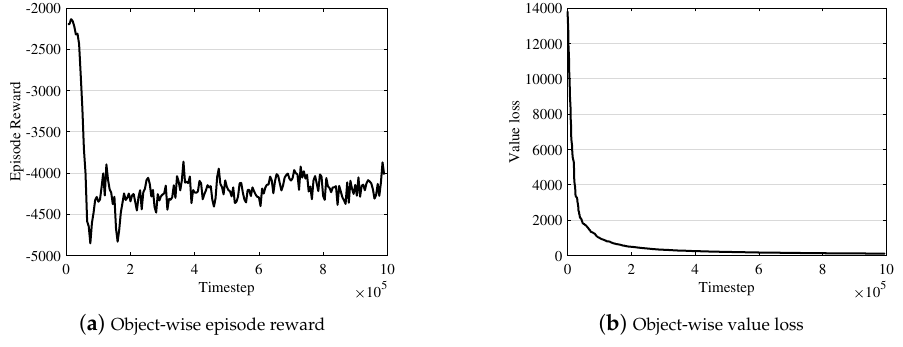
Figure 8. Object-wise reinforcement learning (RL) curve over time.